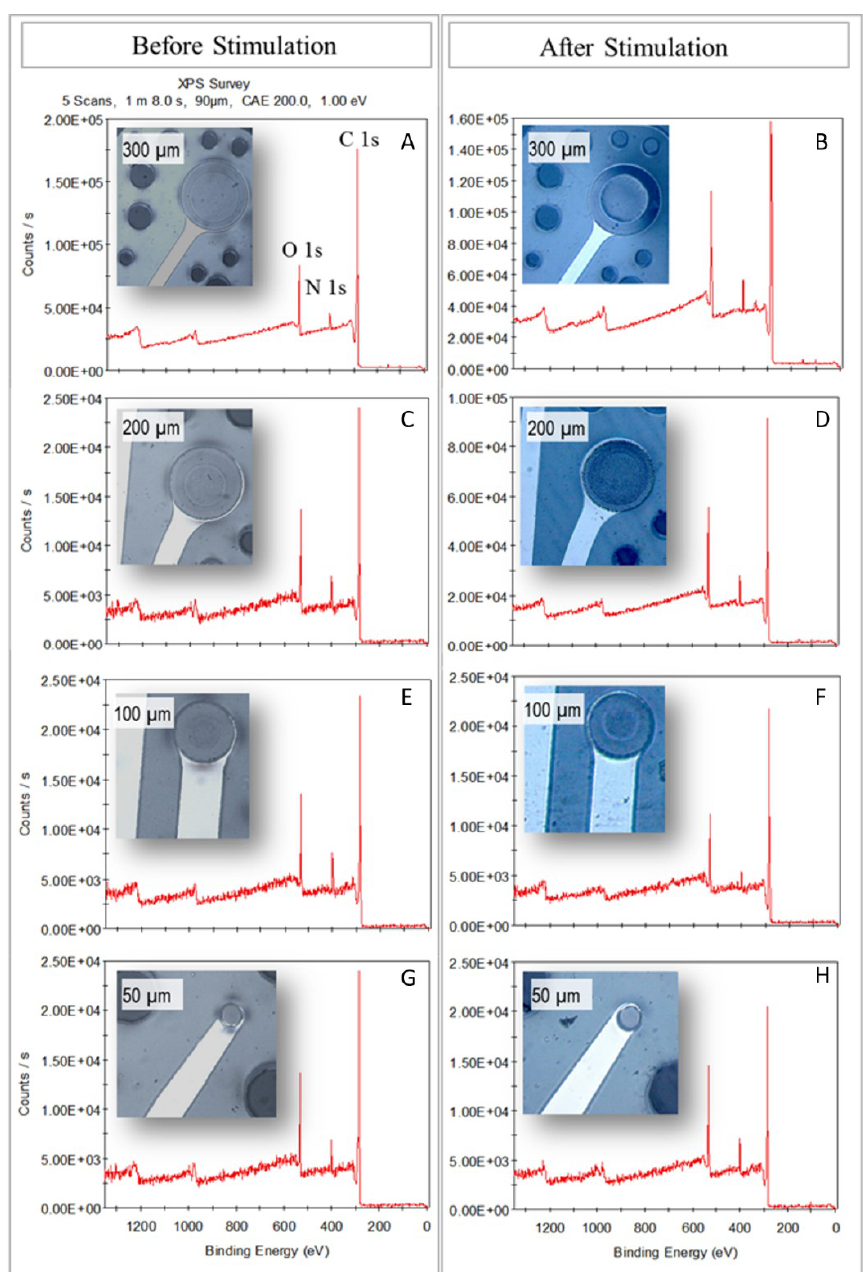
Figure 7. X‐ray photoelectron spectroscopy (XPS) survey spectra of the four‐diameter GC electrodes before ( A , C , E , G ) and after ( B , D , F , H ) stimulation. Insets show pictures of the electrodes with the correspondent diameter.